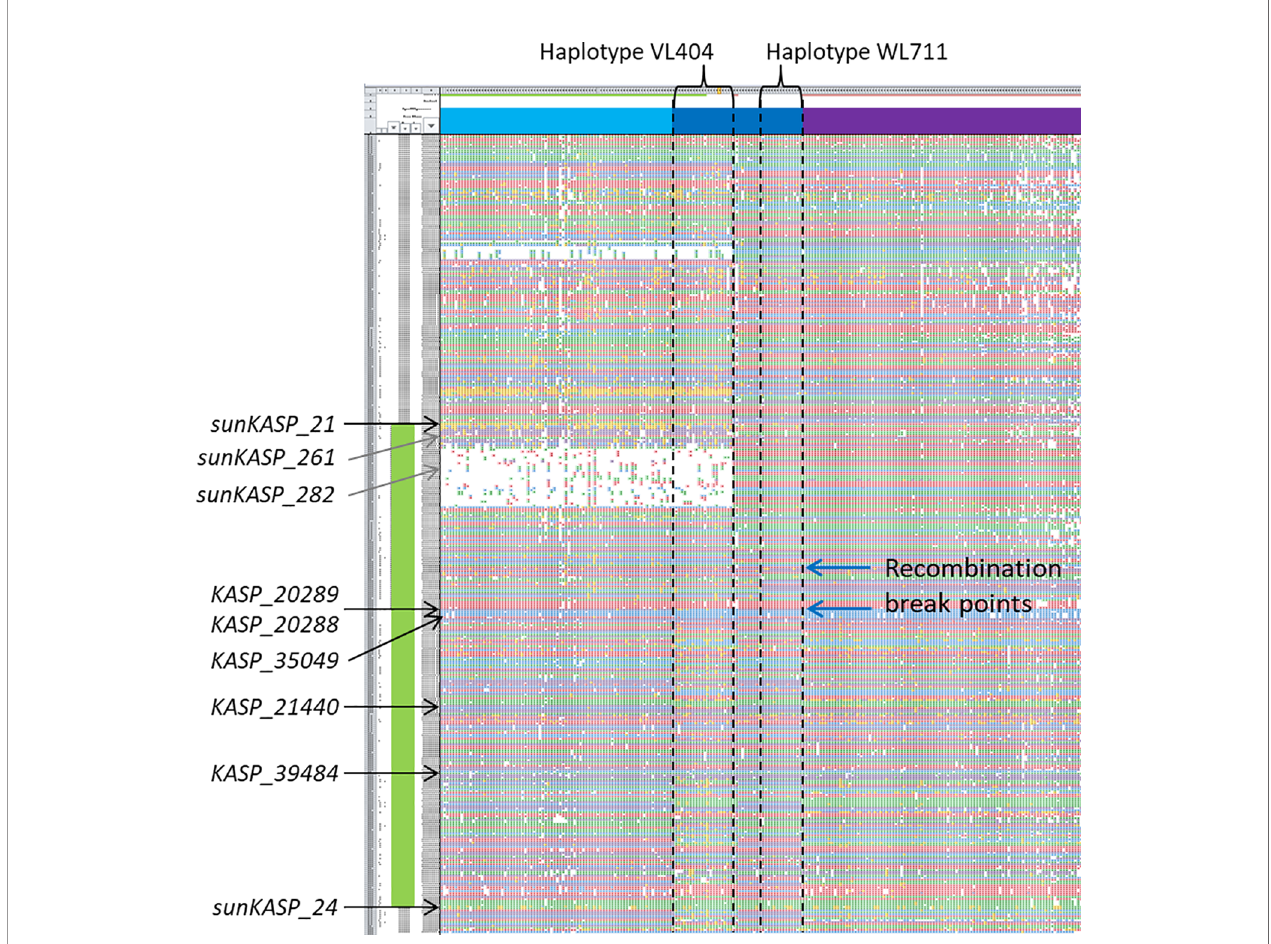
FIGURE 2 | Exome SNP genotypes for 890 globally diverse accessions across the Lr49 region (green box). The sunKASP_21 maps proximal to Lr49 , while KASP_20289, KASP_20288, KASP_35049, KASP_21440, KASP_39484, and sunKASP_24 cosegregate and map distally to Lr49 in the RIL mapping population. Physical mapping positions for the fl anking markers are indicated by black arrows. Two recombination breakpoints present between sunKASP_21 and KASP_20289 are shown by blue arrows. Two additional markers, sunKASP_261 and sunKASP_282 , developed from parental SNPs proximal to the recombination break points and mapped in the RIL population were not linked to Lr49 . The physical mapping position for these two markers is denoted by grey arrows.